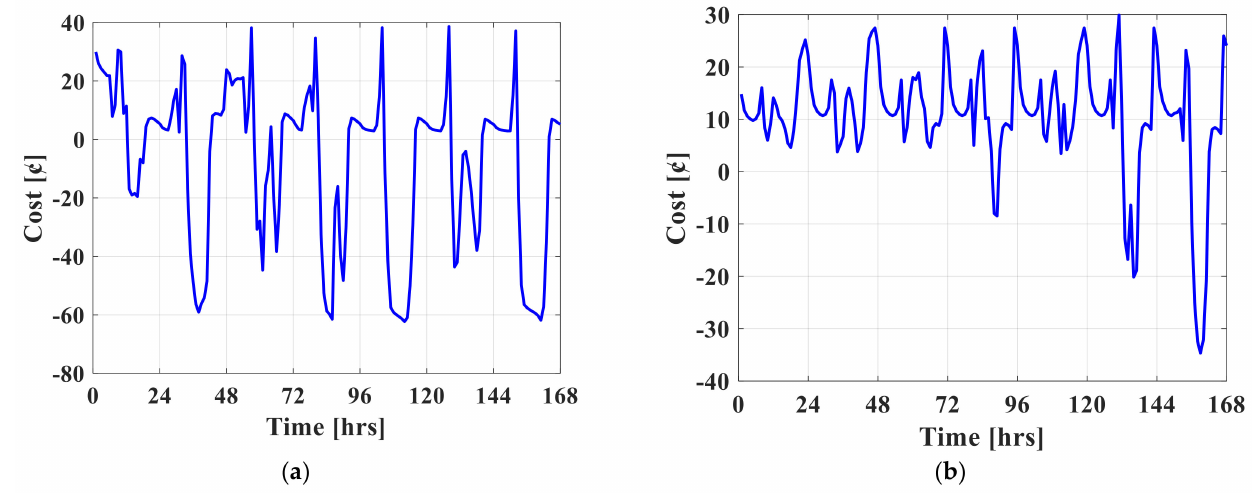
Figure 12. Electricity cost variations under Flat-Flat rates for one week in: ( a ) Summer, and ( b ) Winter.